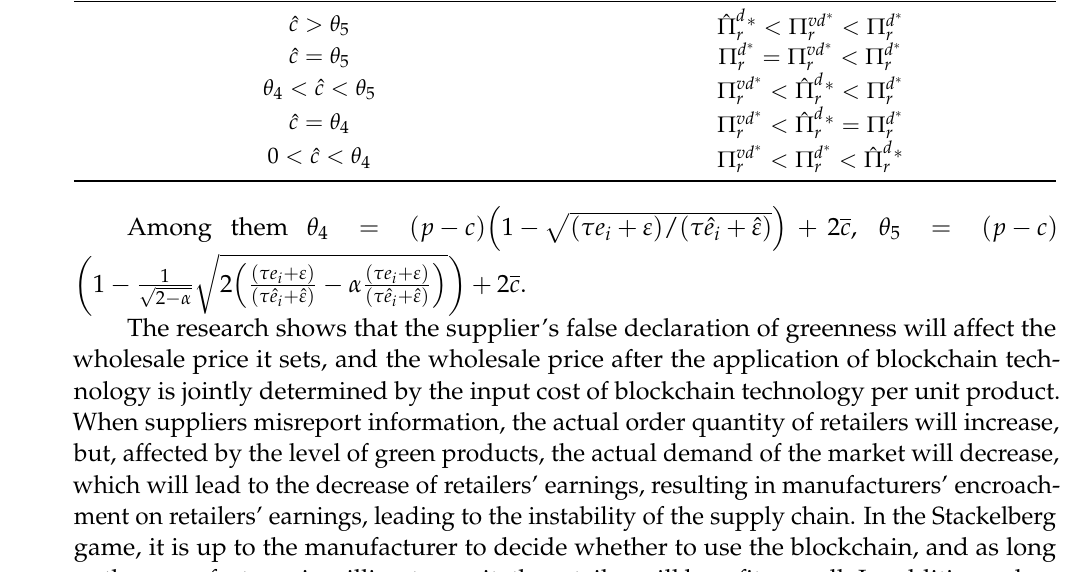
Table 4. Comparison of supplier income under the Stackelberg game.